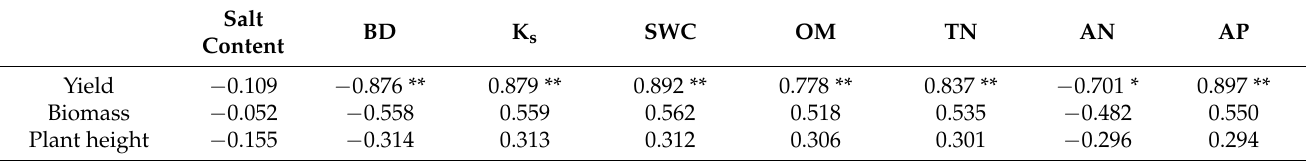
Table 5. Pearson correlation coefficient between the yield, biomass, plant height, and soil